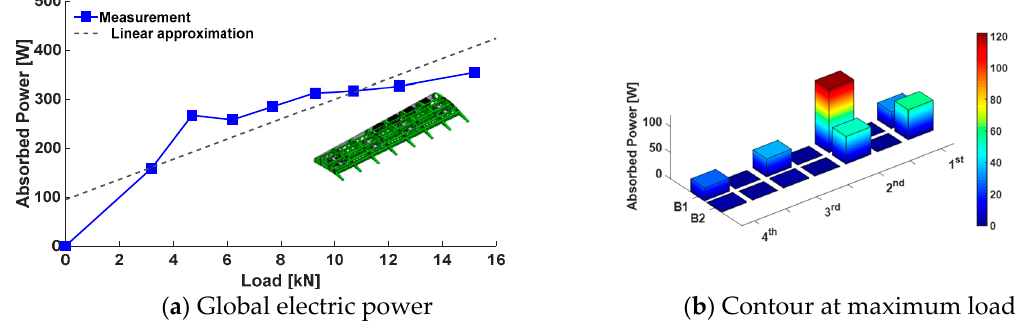
Figure 22. Absorbed power under static load.